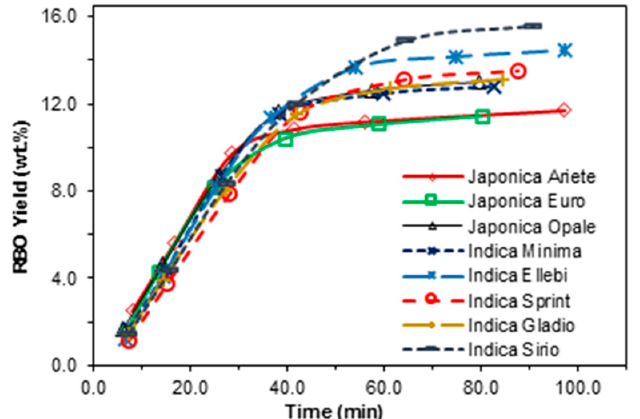
Figure 5. Rice bran oil yield as a function of extraction time for the different rice varieties obtained by supercritical CO 2